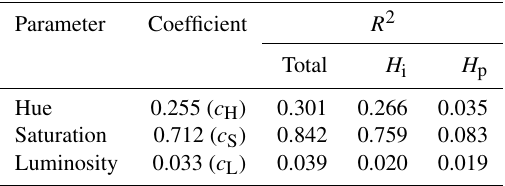
Table 1. The squared correlation coefficients R 2 between melt-pond color and H i and H p in Istomina et al. (2016) and the deduced co- efficients c H , c S , and c L for Eq.